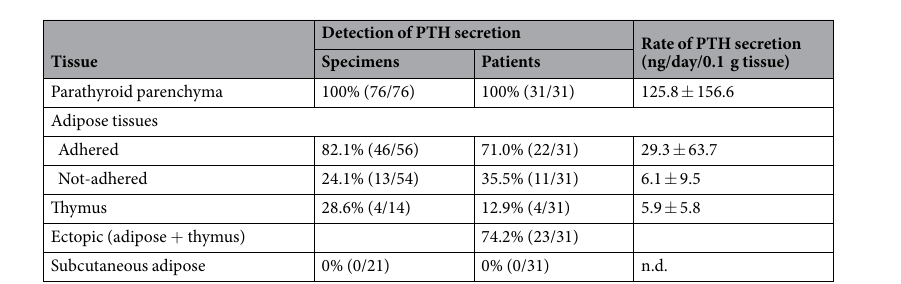
Figure 1. Hyperplastic parathyroid glands removed from hemodialysis patients with secondary hyperparathyroidism. (a) representative hyperplastic parathyroid glands and surrounding adipose tissues removed during parathyroidectomy. Two glands (upper left and lower left) have tightly adhered adipose tissues. One gland (upper right) has no adhered adipose tissues. One gland (lower right) is covered by adipose tissues. These adipose tissues did not adhere to the gland and were removed without mechanical manipulations. The scale of the ruler is a millimeter. (b) a representative immunohistochemical staining for PTH of a hyperplastic parathyroid gland. Bar, 200 μ m.